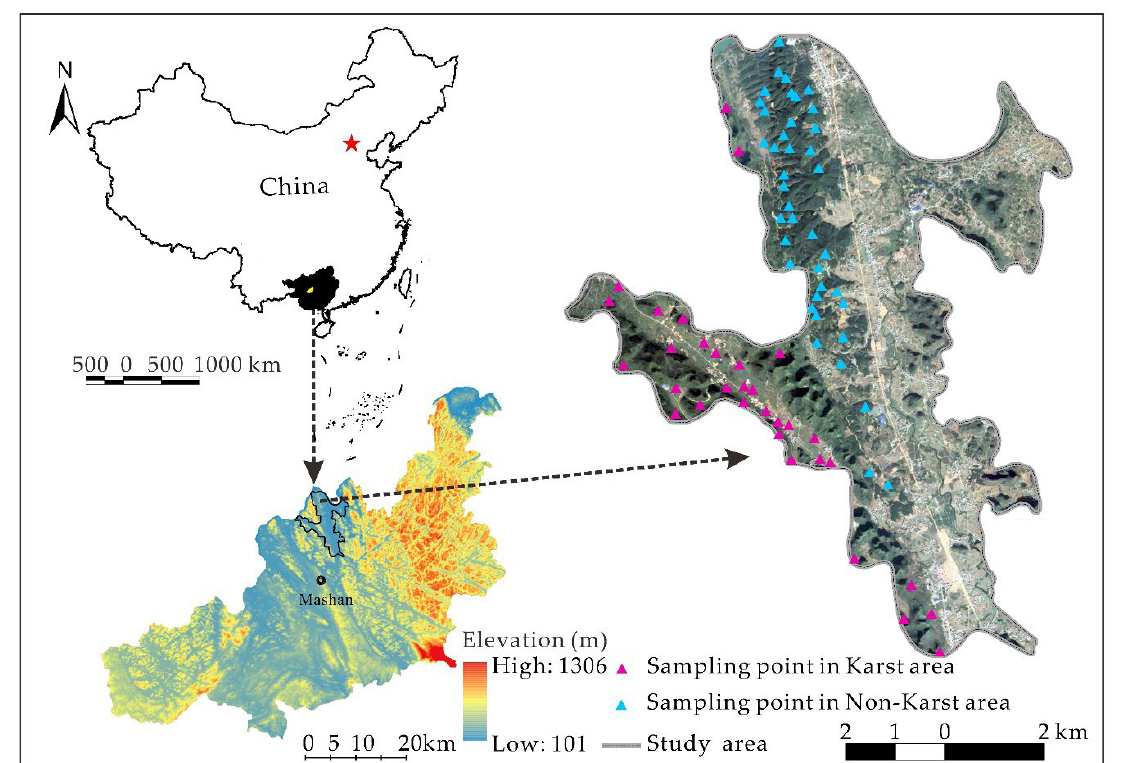
Figure 1. Location of the study area and distribution of sampling points.